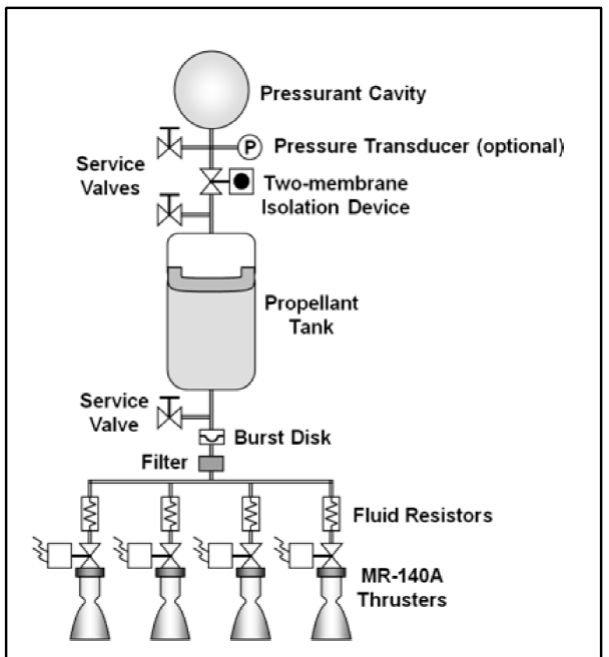
Figure 13. CHAMPS Functional Schematic [32].